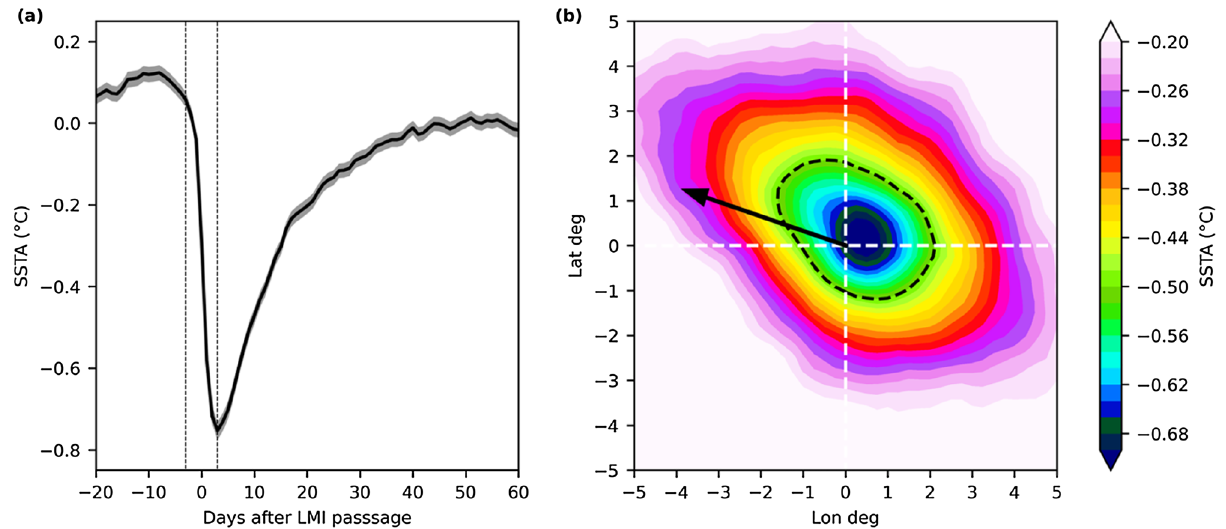
Figure 1. Composite of TC-induced SSTA for 1982–2019. ( a ) Mean time series of SSTA at the location of LMI. The shading shows one standard error. The thin dash black lines highlight 3 days before and after LMI. ( b ) Mean SSTA map 3 days after LMI. The location of LMI is at the origin. The black arrow shows the mean translation direction (not magnitude). The black dash line shows the area of less than − 0.5 °C